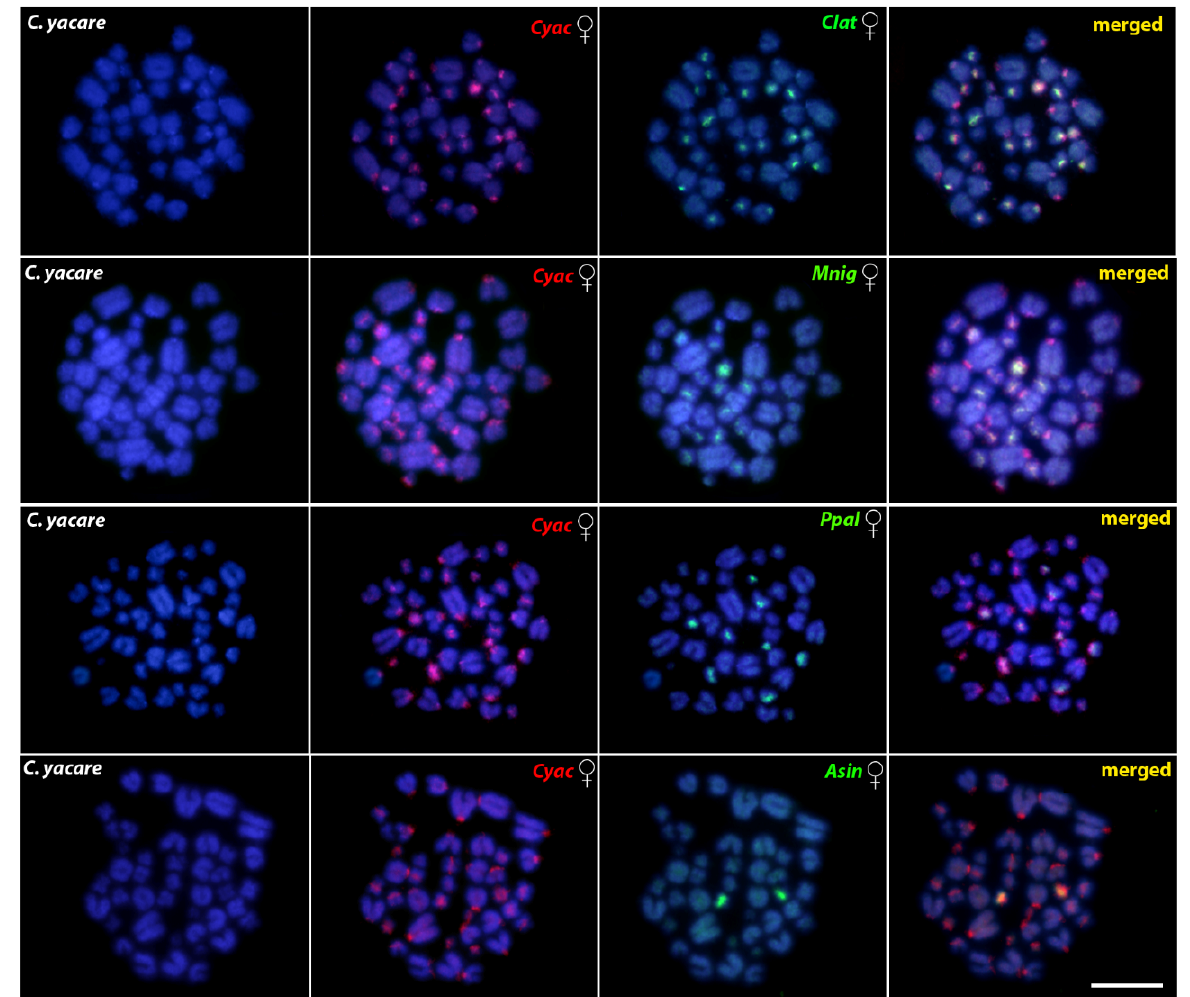
Figure 7. Mitotic chromosome spreads of Caiman yacare females after CGH—inter-specific hybridizations. First column: DAPI images (blue). Second column: hybridization pattern of the female-derived probe (red) of C. yacare . Third column: hybridization pattern of the female-derived probe (green) of each analyzed species. Fourth column: merged images of both genomic probes and DAPI staining. The common genomic regions are depicted in yellow. Clat = C. latirostris, Cyac = C. yacare, Mnig = M. niger, Ppal = P. palpebrosus, and Asin = A. sinensis . Bar = 10 µm.